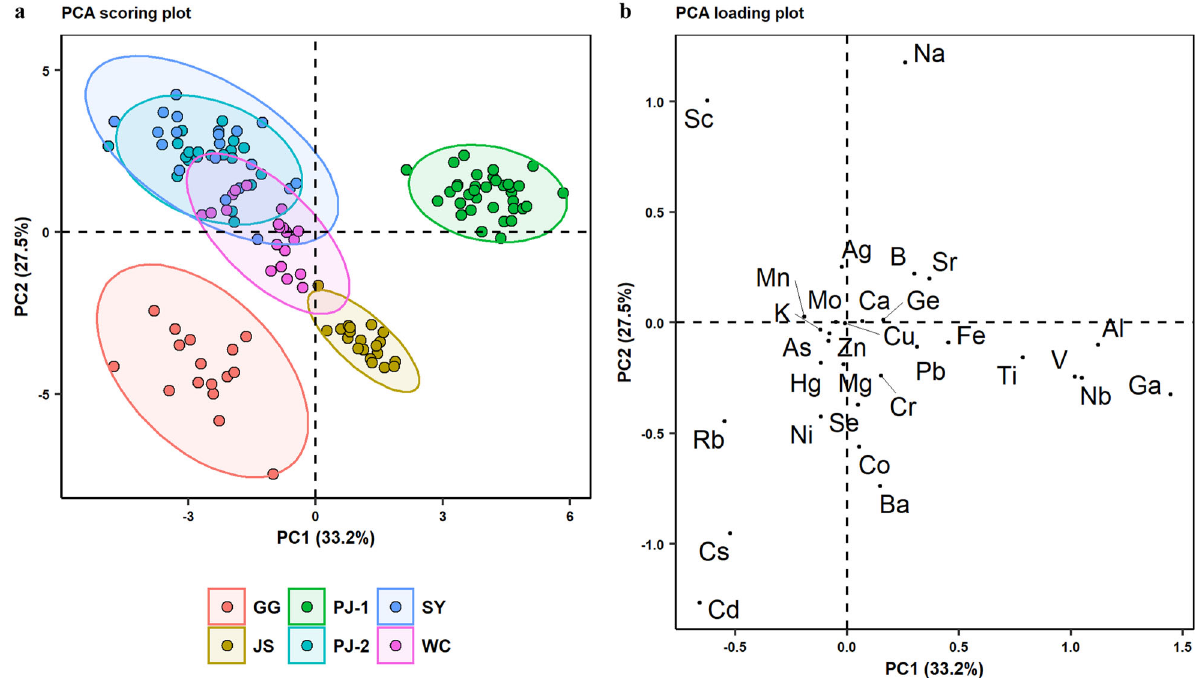
Fig. 1 PCA analysis of the 30 elements measured in the 131 Chinese GI rice samples. a Scoring plot of PC1 and PC2, with 95% con fi dence interval eclipse. b Loading plot of all features projected on the fi rst two